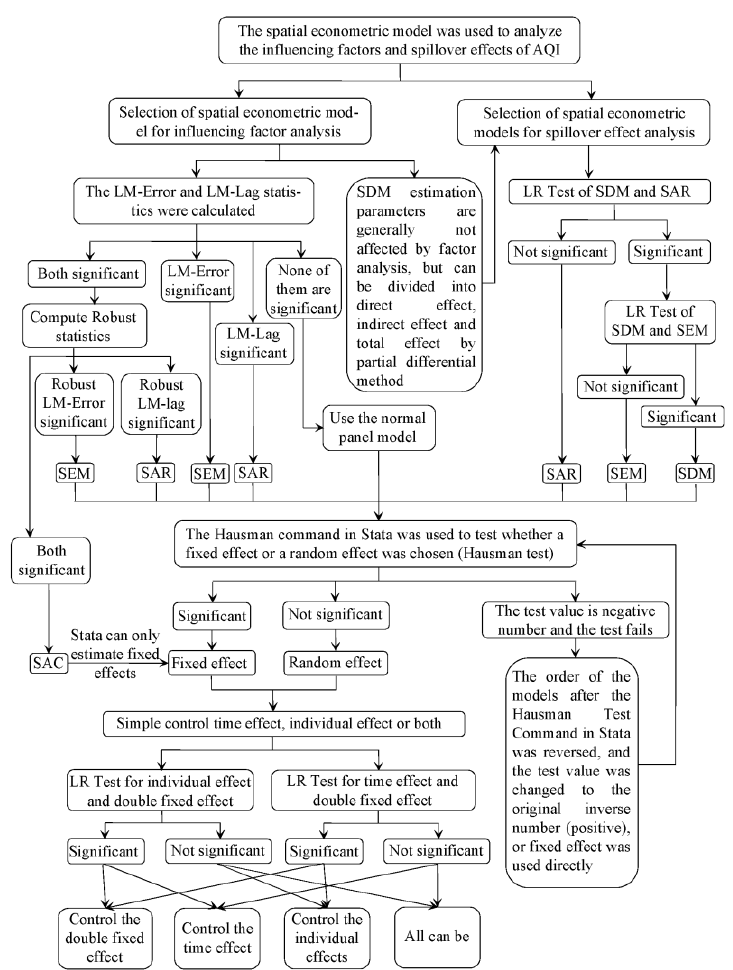
Figure 2. Tests of spatial econometric models and the selection of optimal model.